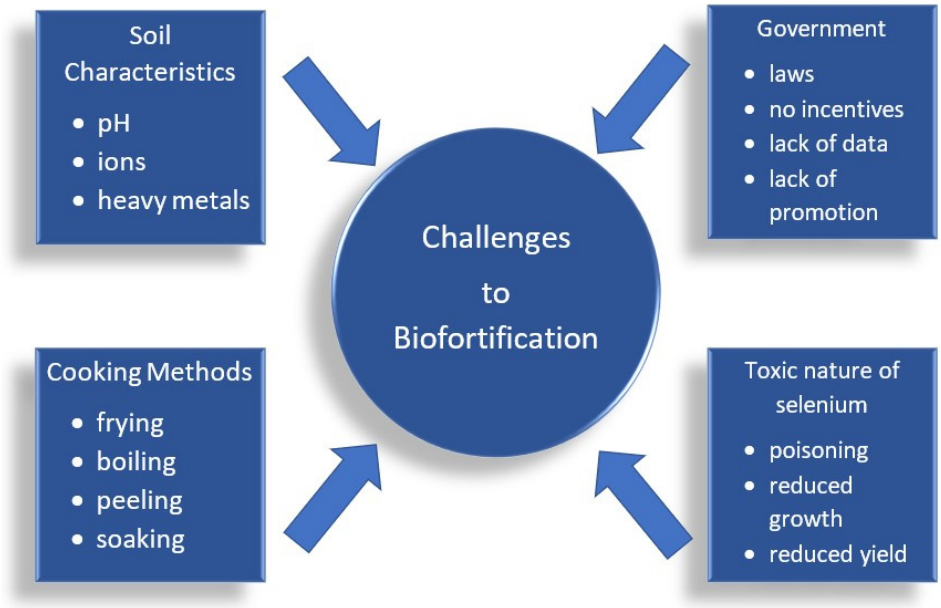
Figure 3. Challenges to biofortification.